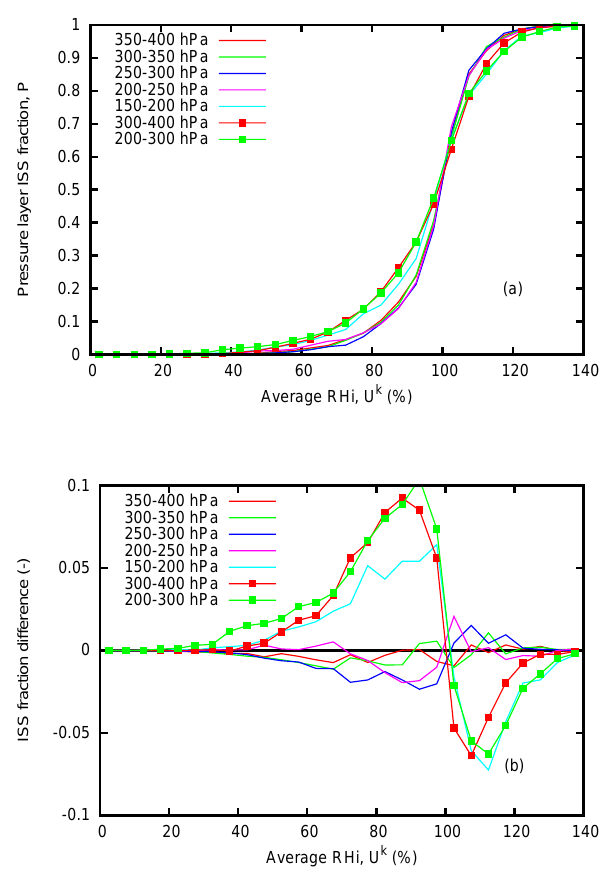
Fig. 9. The relationship between average RHi and the ISS fraction within individual 50hPa and 100hPa pressure layers is shown in panel (a) . The differences between them are shown in panel (b) . These data are derived from six high resolution radiosonde launch stations within the British Isles (January 2002–December 2006).